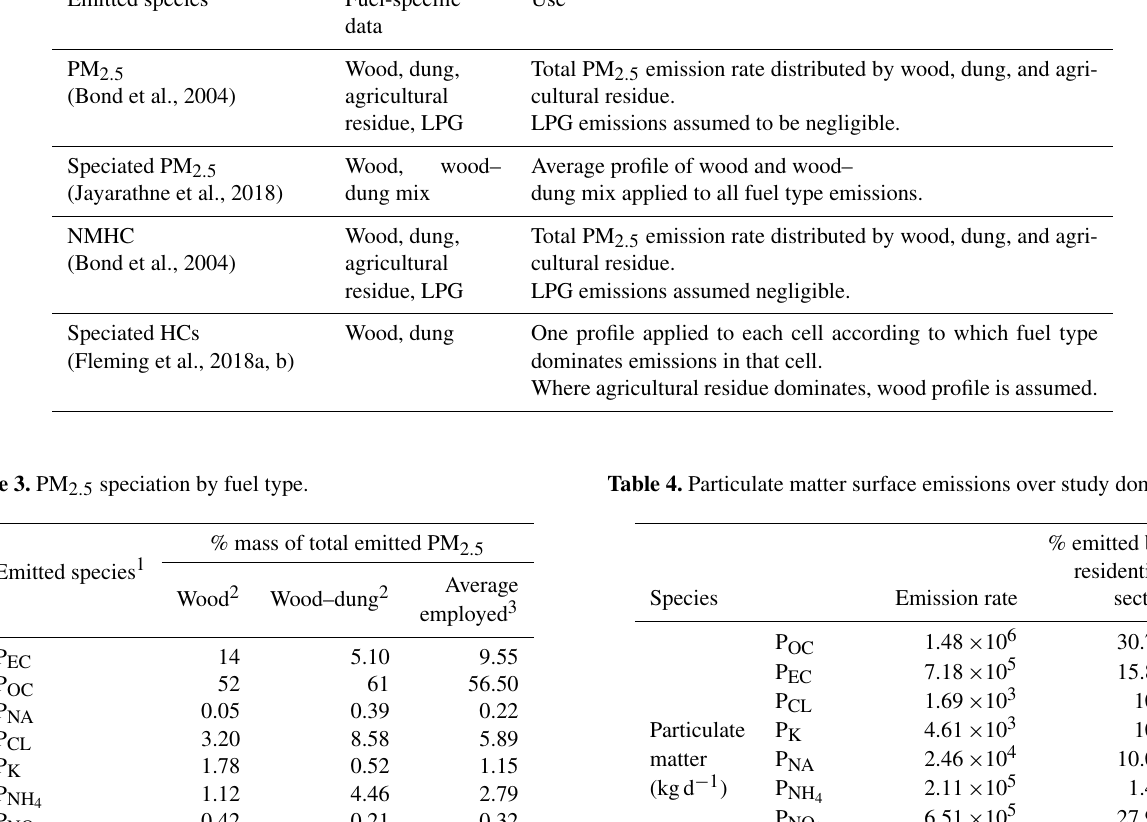
Table 2. Residential PM 2 . 5 and NMHC emissions speciation. Emitted species